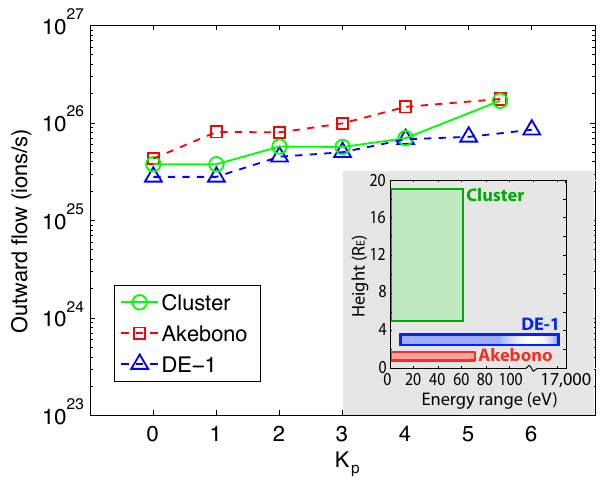
Fig. 12. Comparison to Akebono and DE-1. Comparison of the to- tal ion outflow (ions/s) to measurements from DE-1 and Akebono for high F 10 . 7 (F 10 . 7 > 150). The instrument energy ranges and al- titudes covered by the spacecraft are displayed in the lower right corner. (Note that the spacecraft potential screening effect is not taken into account for Akebono and